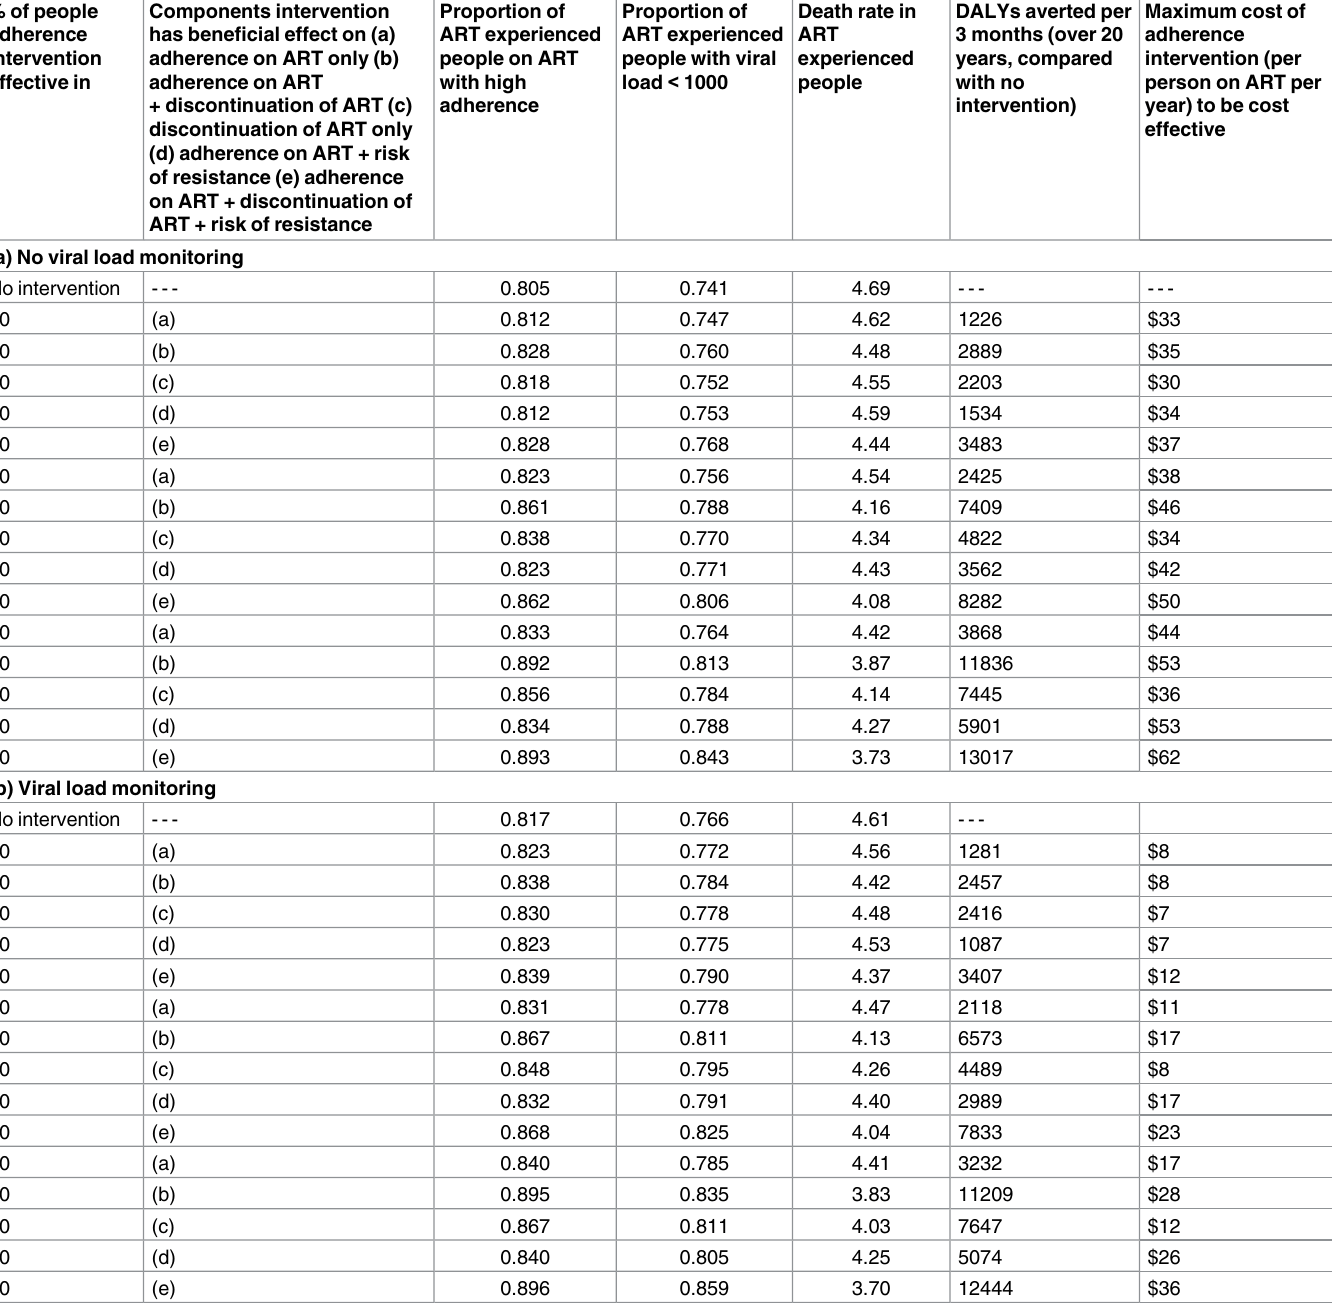
Table 2. Outcomes of adherence interventions according to the components the intervention has an effect on, the percent of people the interven- tion is effective in and whether viral load monitoring is employed, all in the context of an intervention with a durable effect. % of people Components intervention adherence has beneficial effect on (a) intervention adherence on ART only (b) effective in adherence on ART + discontinuation of ART (c) discontinuation of ART only (d) adherence on ART + risk of resistance (e) adherence on ART + discontinuation of ART + risk of